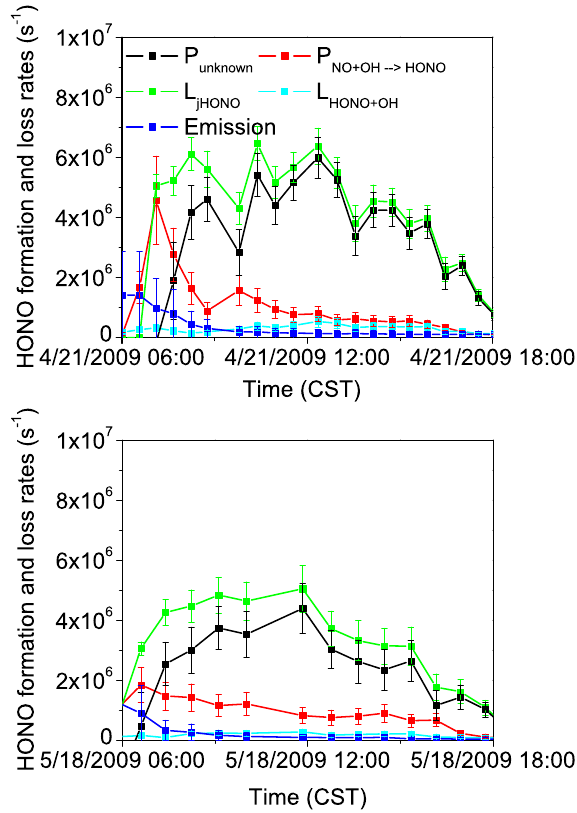
Fig. 5. Timeseries of HONO formation and removal rates in the lower height interval on 21 April 2009 (upper) and 18 May 2009 (lower). Please note that errors were propagated from the statistical uncertainties of the